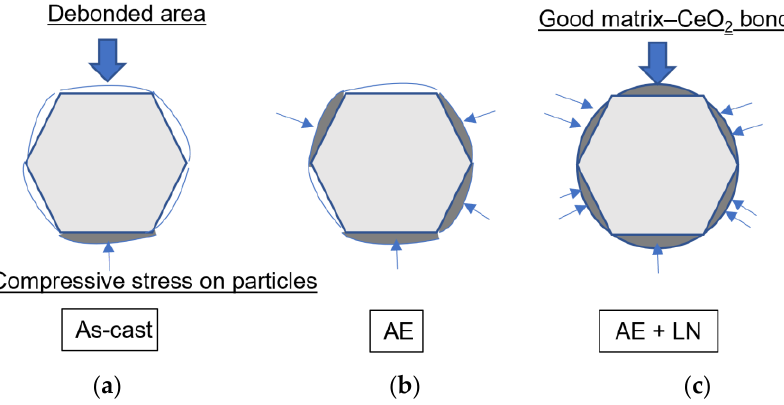
Figure 5. Schematic diagram showing the improvement in Mg/CeO 2 interfacial bonding and increase